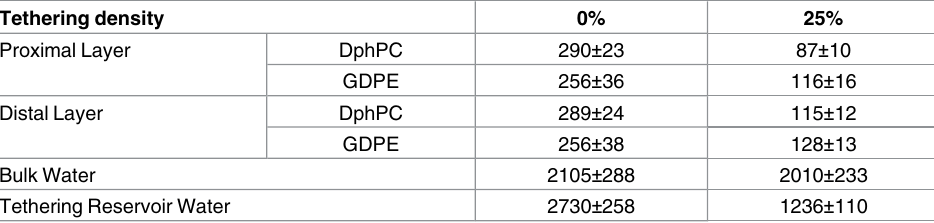
Table 1. Lateral Diffusion Coefficient D || (nm 2 / μ